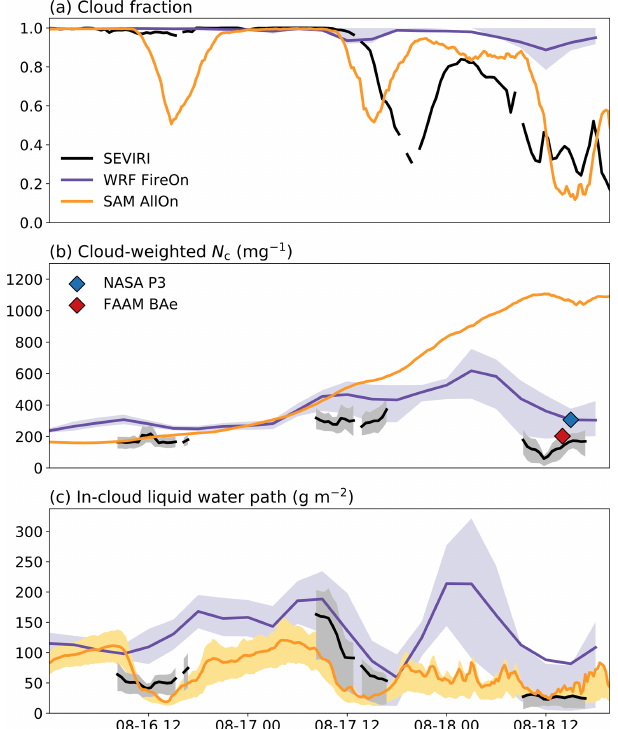
Figure 21. Comparison of SEVIRI retrievals and model output over the course of the Lagrangian trajectory. Lines represent mean val- ues and shading interquartile ranges for (a) cloud fraction, (b) cloud droplet number concentration, and (c) in-cloud liquid water path. The markers in panel (b) represent the average Nc weighted by cloud water content for the ORACLES (blue) and CLARIFY (red)